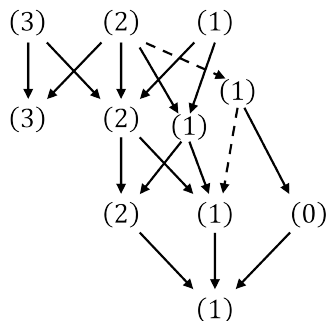
Figure 18: The 45-dimensional indecomposable rank-4 tensor representation of 4 d CCA rotations. There are two ( 1 ) sectors at order 3 that can not be diagonalized. (( 3 ) → ( 1 )) ⊗ 4 = [ 35 ] ⊕ 3 × [ 45 ] ⊕ 2 × [ 20 ] ⊕ 3 × [ 15 ] ⊕ [ 1 ] , where [ dim ] represents